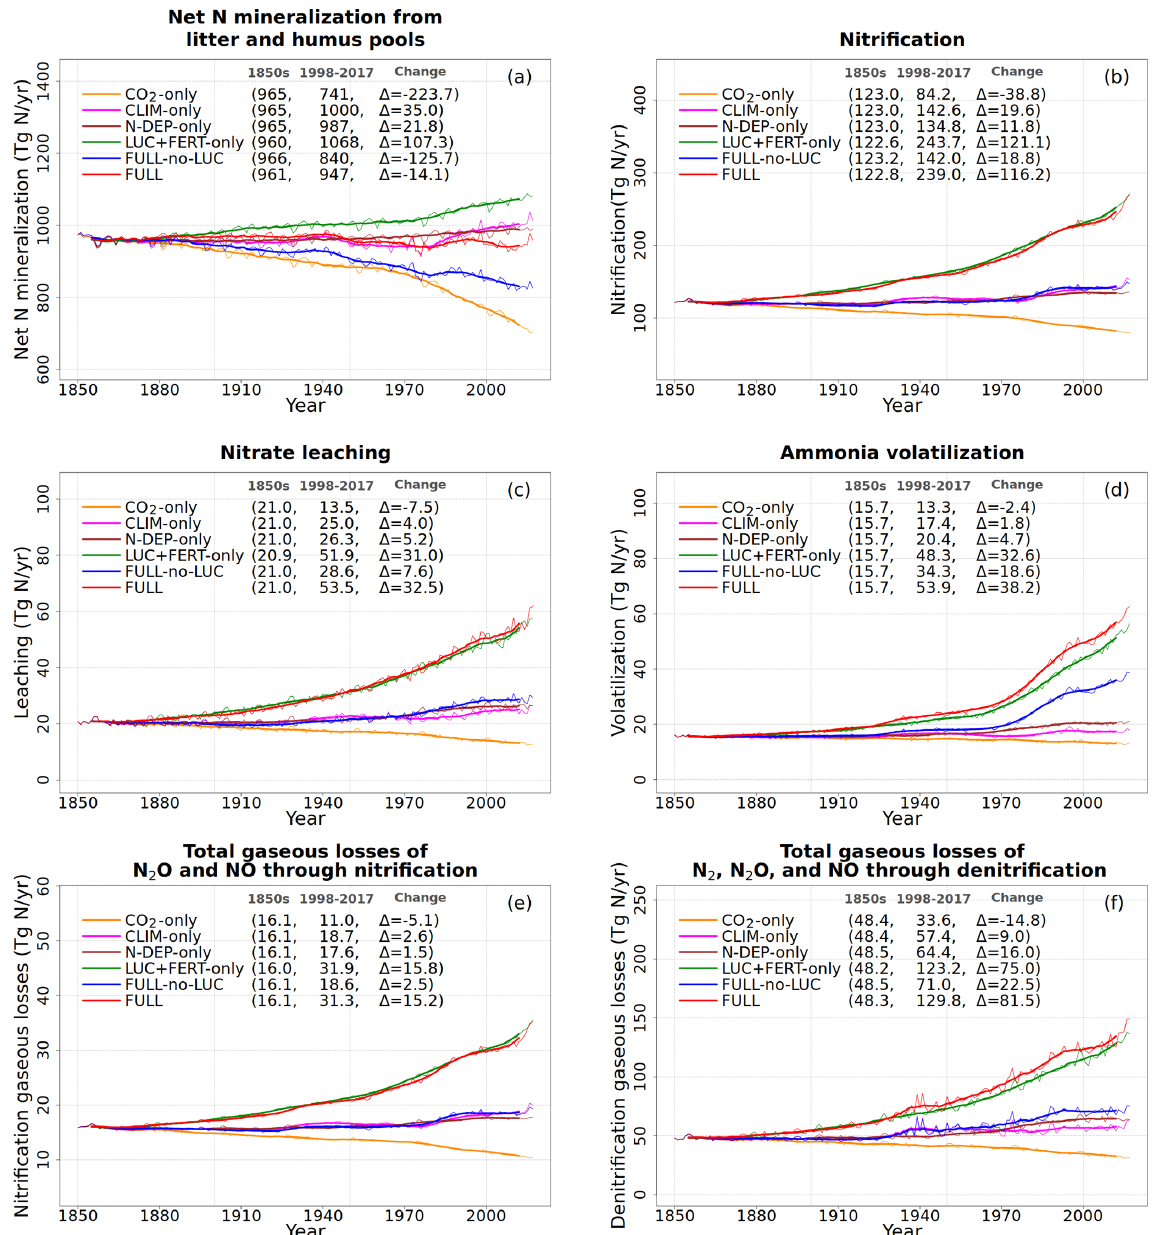
Figure 8. Global annual values of net mineralization (a) , nitrification (b) , NO − associated with nitrification (e) and denitrification (f) from the primary six simulations. The values in the parentheses for legend entries show the average for the 1850s, the average for the 1998–2017 period, and the change between them. The thin lines show the annual values, and the thick lines show their 10-year moving